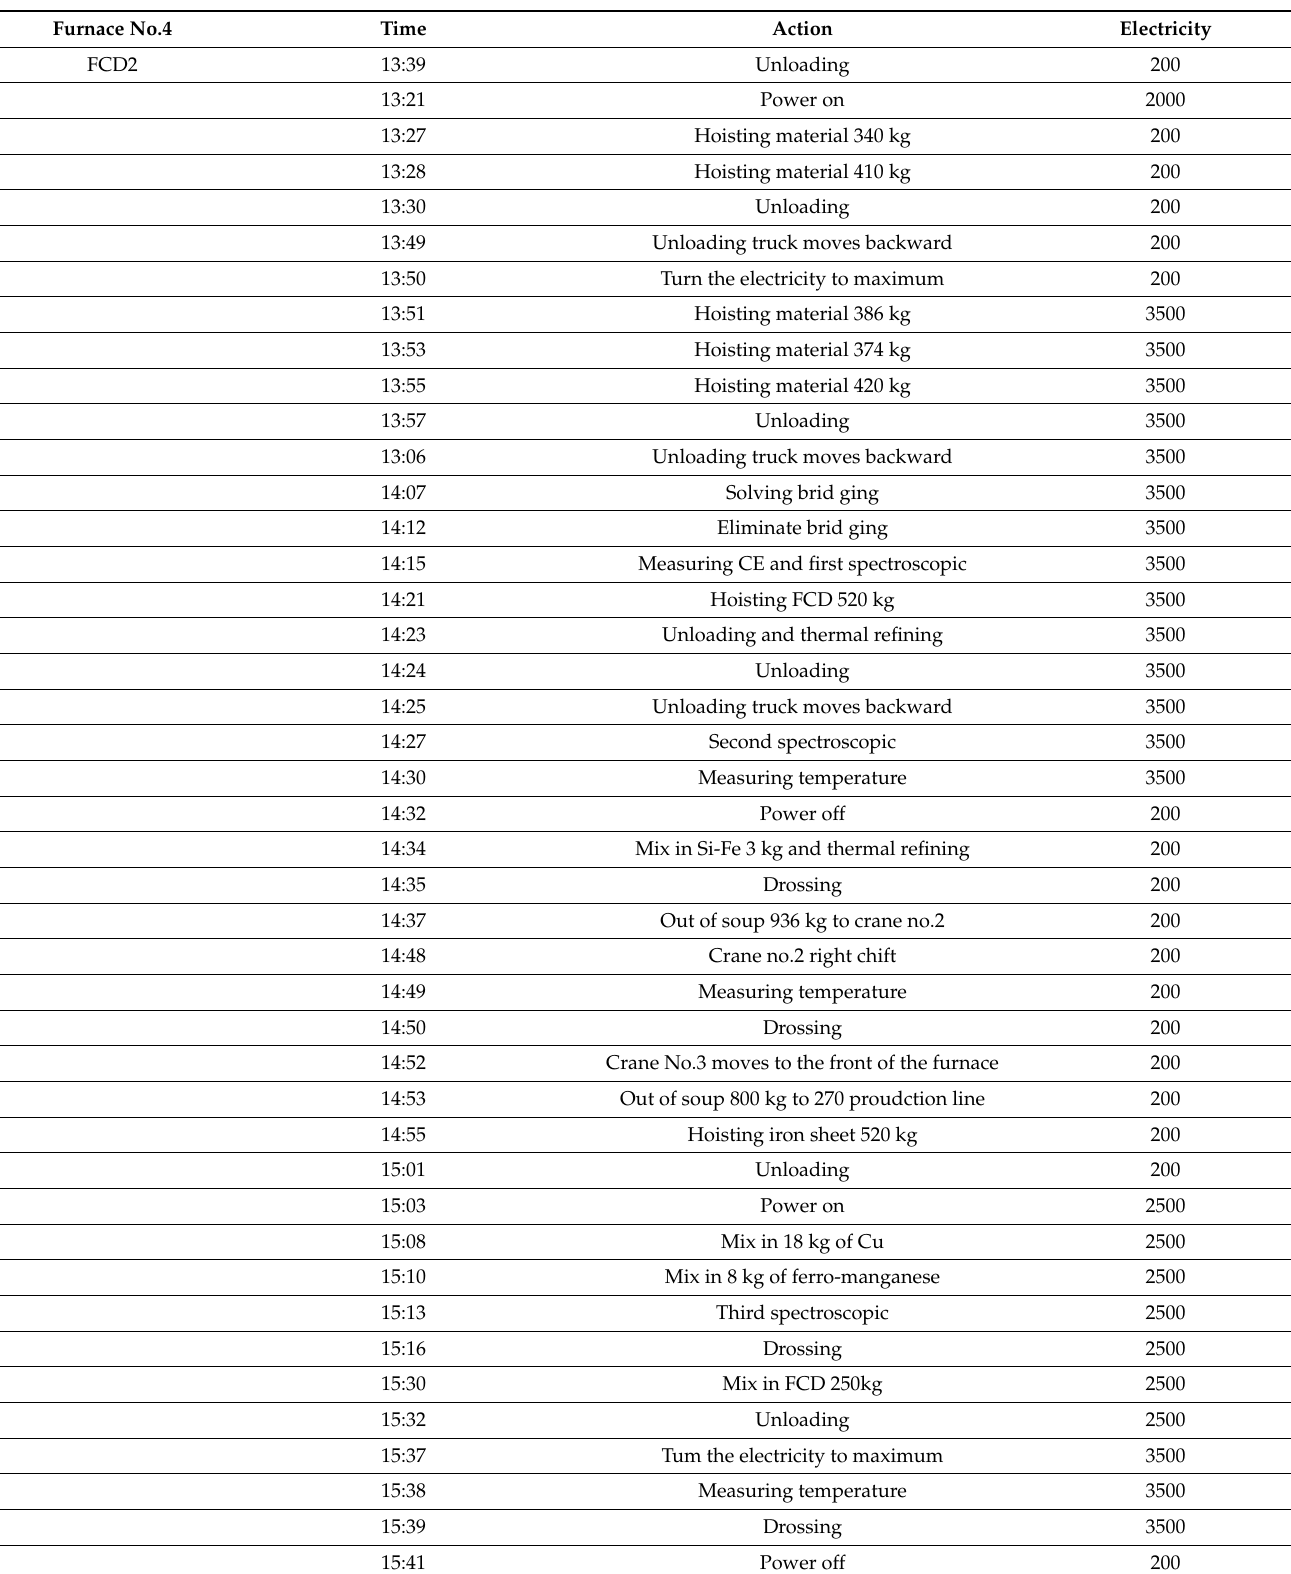
Table 3. FCD2 thermal refining actions in furnace